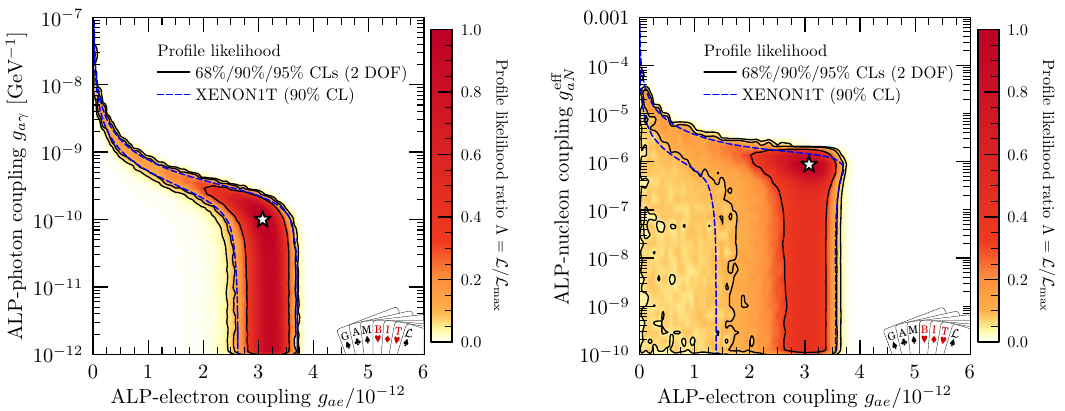
Figure 1. Comparison between our 68% / 90% / 95% CL regions (solid black lines) and the XENON1T 90% CL region (dotted blue lines) for the solar ALP effective couplings. The inverse Primakoff contribution is not included. Stars denote our best-fit point.